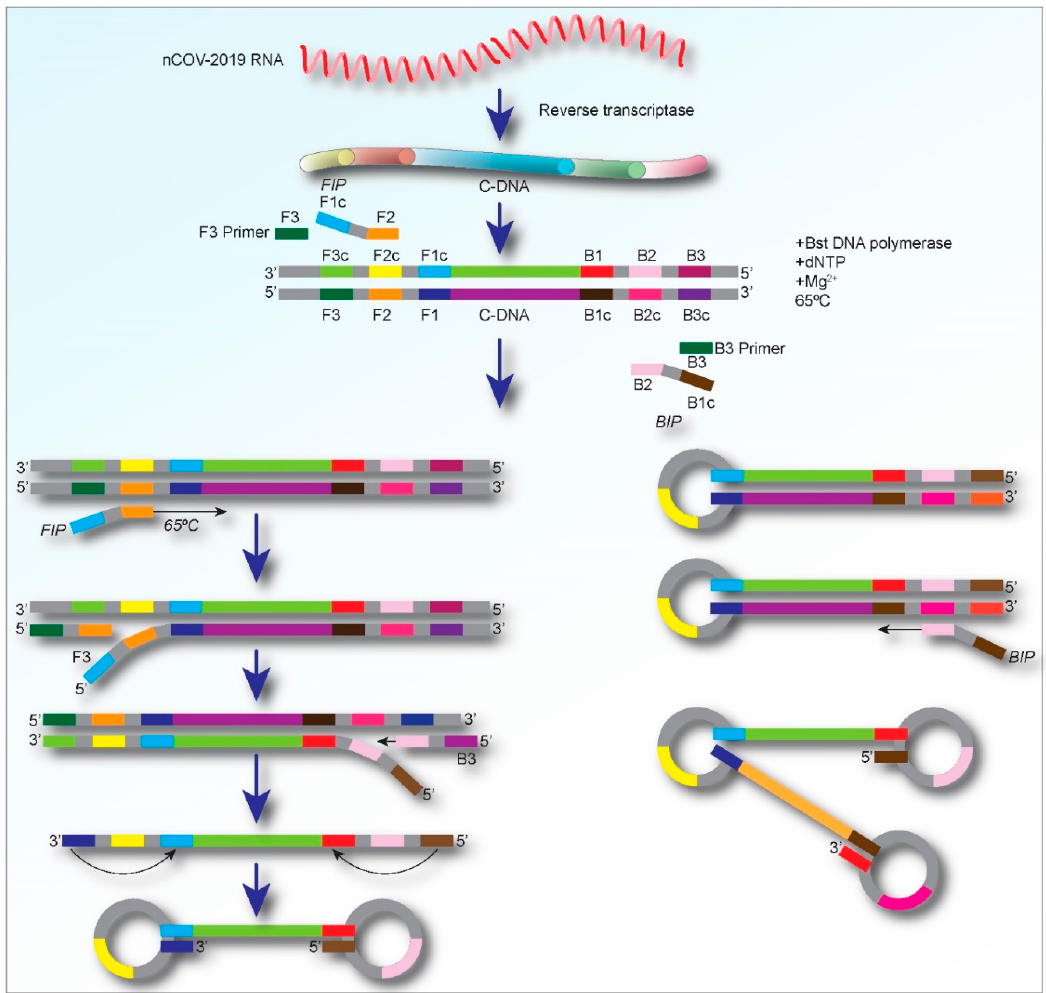
Figure 2. Schematic representation displaying the process of the amplification for the RT-LAMP assay. Initially, the LAMP primers bind to the complementary target cDNA sequences (in the case of RNA viral detection), and dumbbell-shaped DNAs are produced. Then, during the cycling amplification step, several copies of such dumbbell DNAs are continuously produced. The products formed during the cycling amplification step are used in the elongation phase to generate amplified DNA with various sizes.